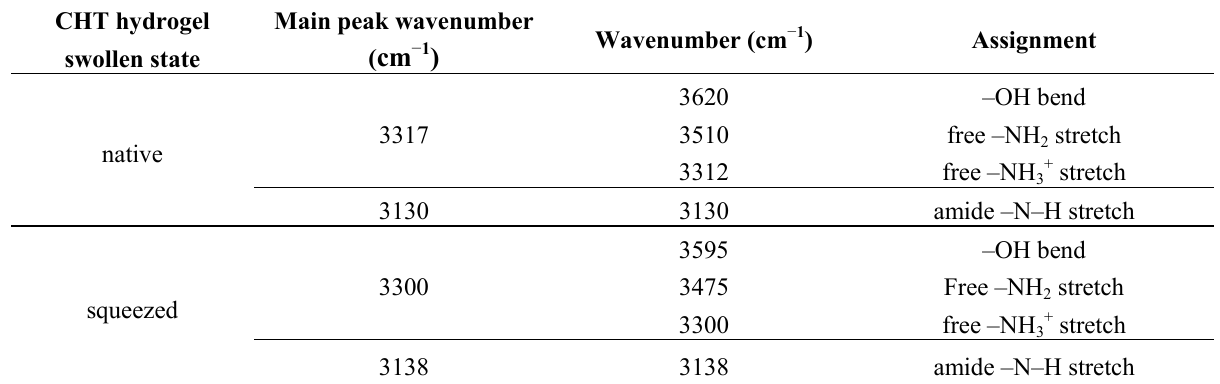
Table 7. Assignment of bands of spectra for CHT hydrogels ( a ) native; and ( b ) squeezed, both in swollen state, present in the region between 3000 and 3650 cm − 1 CHT hydrogel